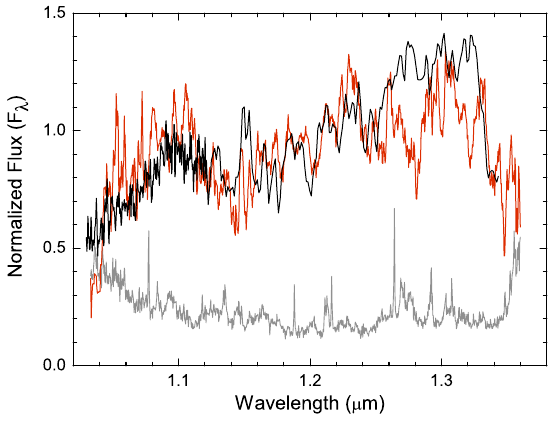
Figure 2. Gemini/NIRI spectrum of (cid:1) Cancri B ( red ). The error spectrum is plotted in gray . The spectrum of 2MASS 0028 ( black ) is over ploted, its spectral type in NIR is L3 and in optical is L4.5.